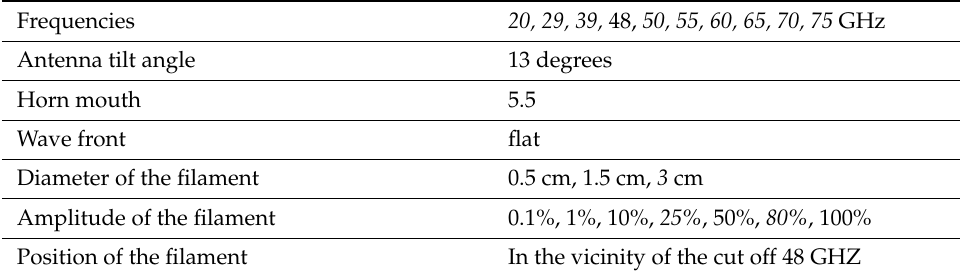
Table 2. Parameters of the performed modelling for circular filaments.